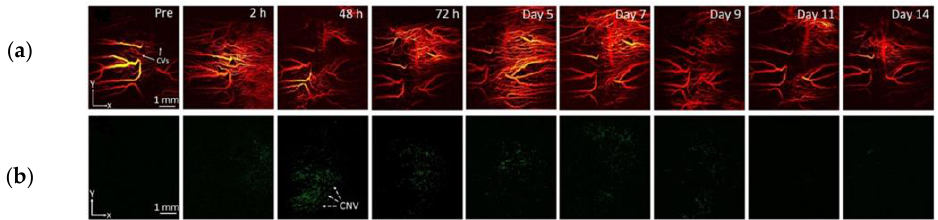
Figure 10. Longitudinal in vivo PAM images at different wavelengths: ( a ) 578 nm and ( b ) 650 nm before then GNS injection and 2 h, 48 h, 72 h, 5 d, 7 d, 9 d, 11 d and 14 d after the GNS injection (0.4 mL, 5 mg/mL). White arrows show choroidal vessels (CVs) and white dotted arrows show choroidal neovascularization (CNV) [109].